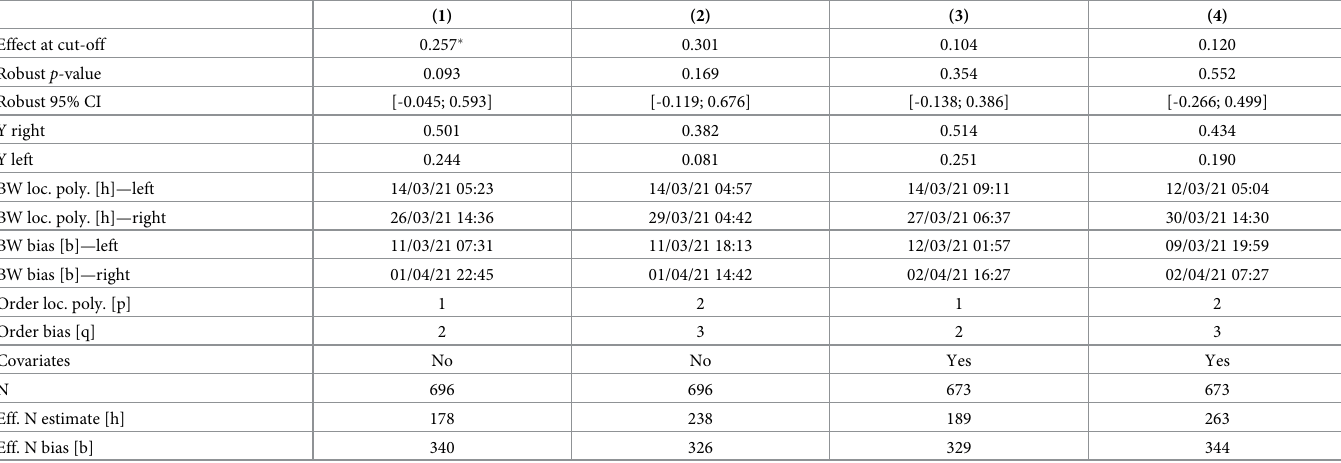
Table 7. RDD estimates with a different outcome definition: Y = 1 if ‘Yes, absolutely‘, else Y = 0.